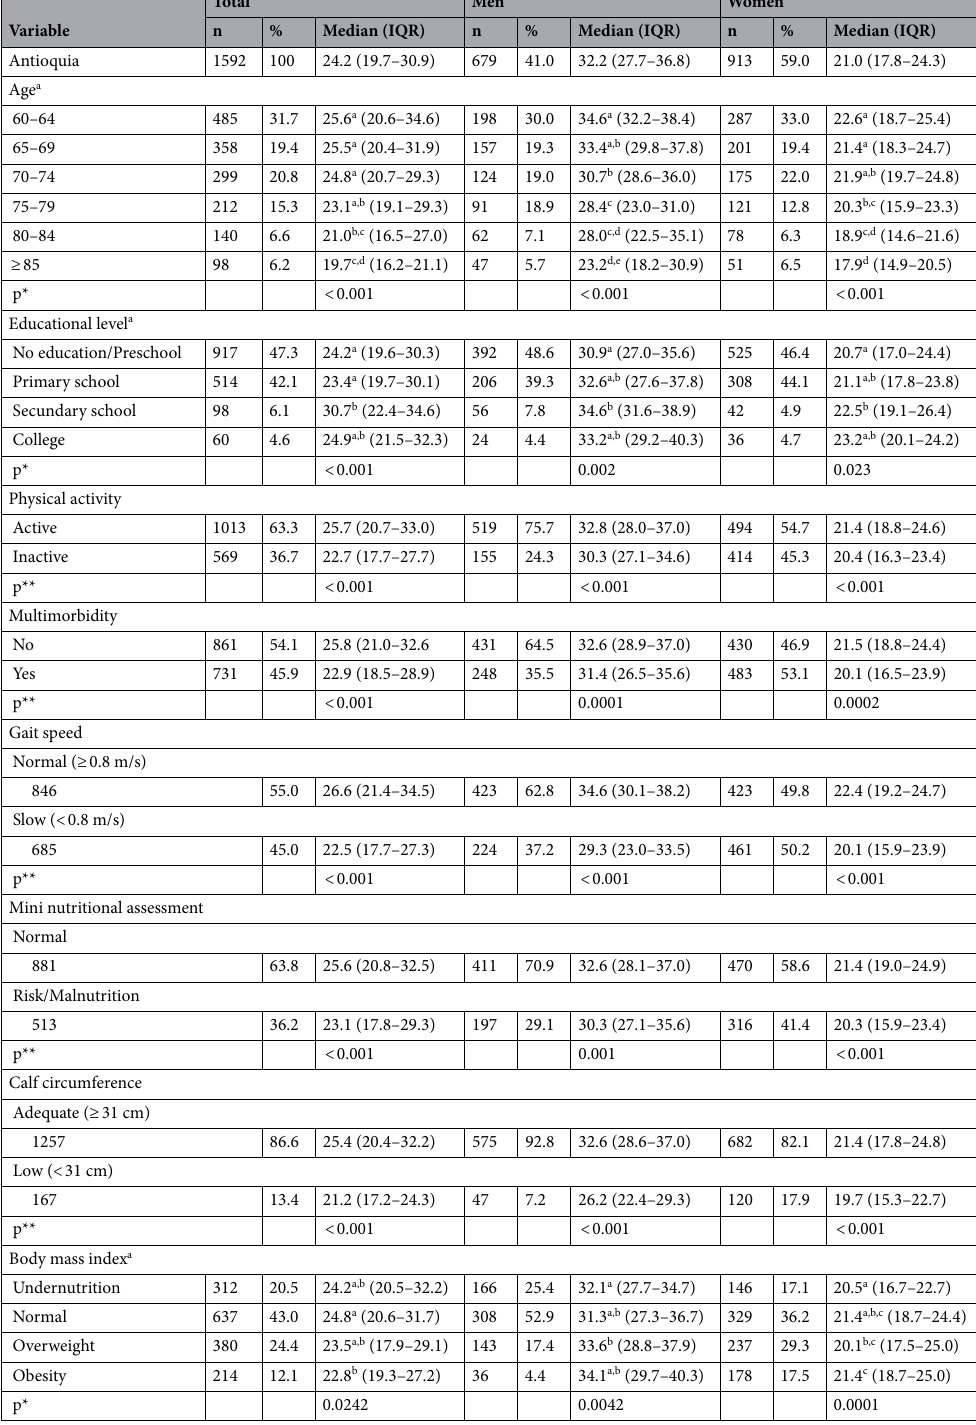
Table 1. Distribution of handgrip strength and demographics, health, functionality, and anthropometrics characteristics by sex. Median (IQR): median (percentile 25—percentile 75). *Kruskal Wallis test. Multiple comparison Dunn’s post-hoc test **U Mann Whitney test. a Different letters in same column indicate significant differences between